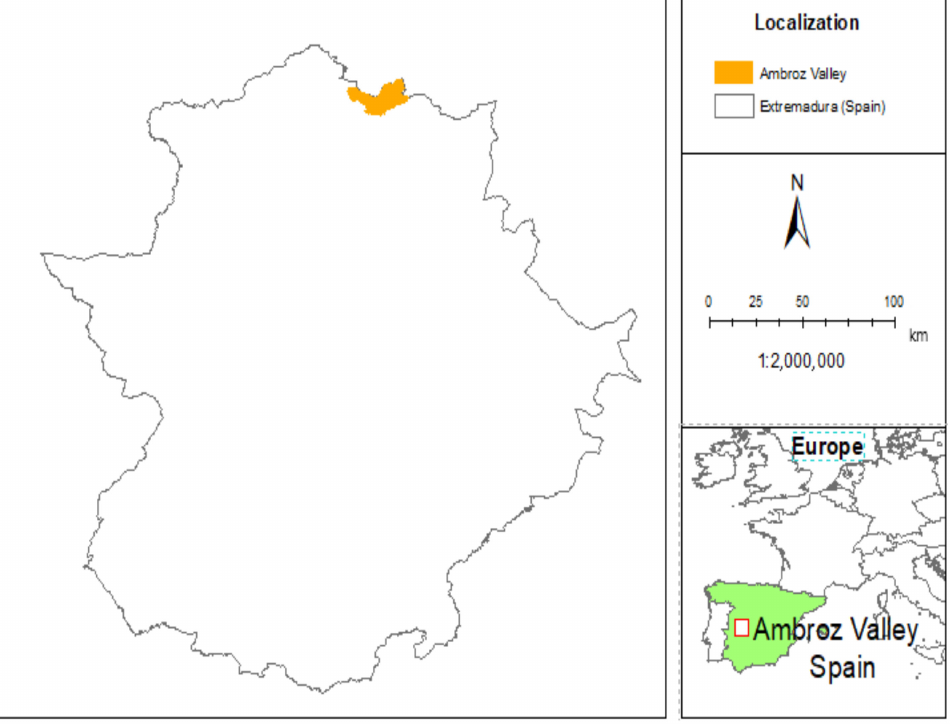
Figure 2. Map of location of Ambroz